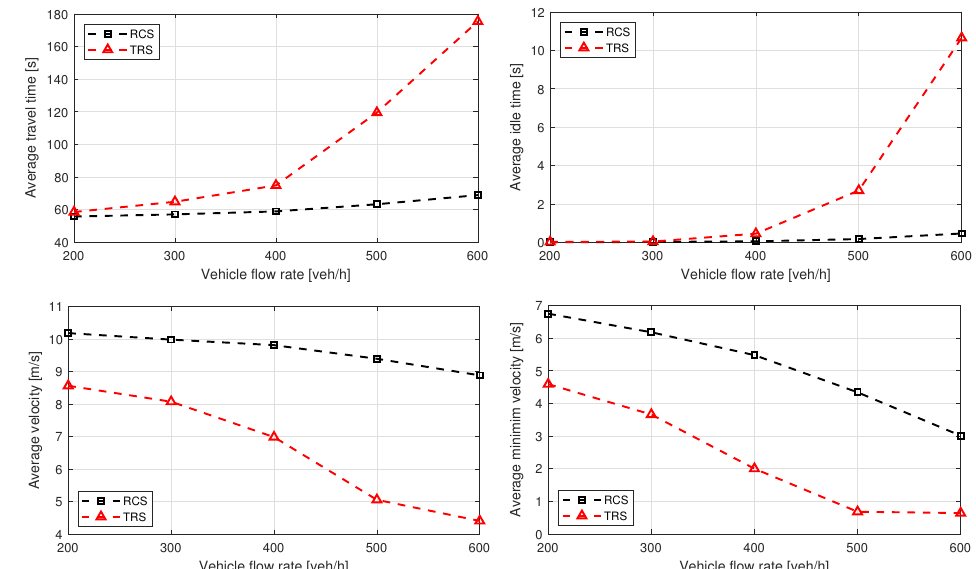
Figure 7. Case 2 performance comparison of roundabout control system (RCS) proposed in this paper and traditional roundabout system (TRS). The North and South lanes have twice the traffic flow of the East and West lanes, and the circulating flow rates are equal to the entry flow rates. The results are plotted against traffic flow of lower density lanes. The sub-figures show improvements in average traveling time, average idling time, average velocity, and average minimum velocity for the unbalanced traffic